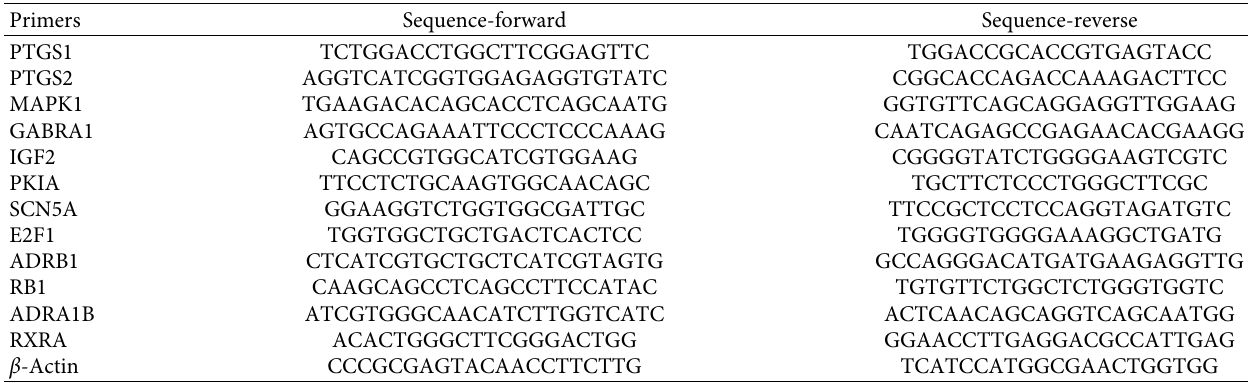
Table 1: Primers used for real-time